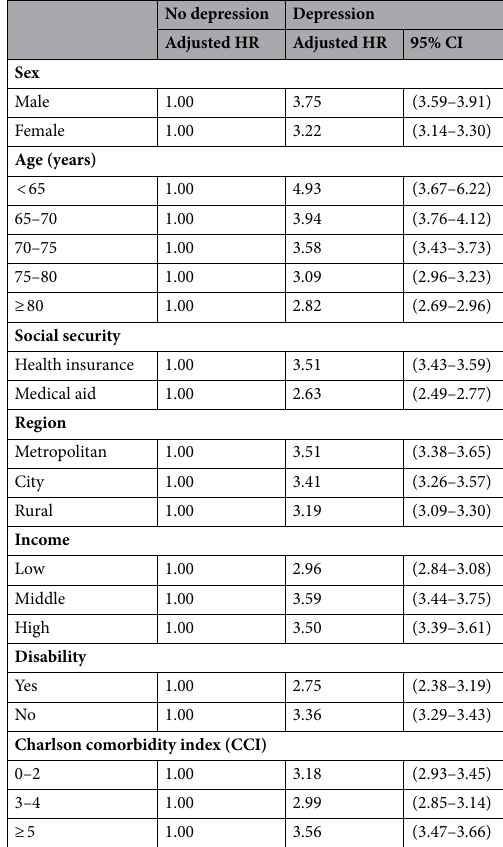
Table 3. Subgroup analysis of association between Alzheimer’s disease risk and covariates, according to history of depression.